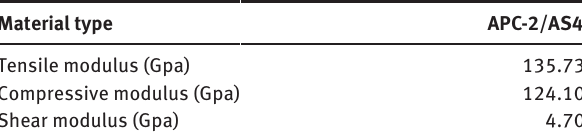
Table 3: Stiffness properties of